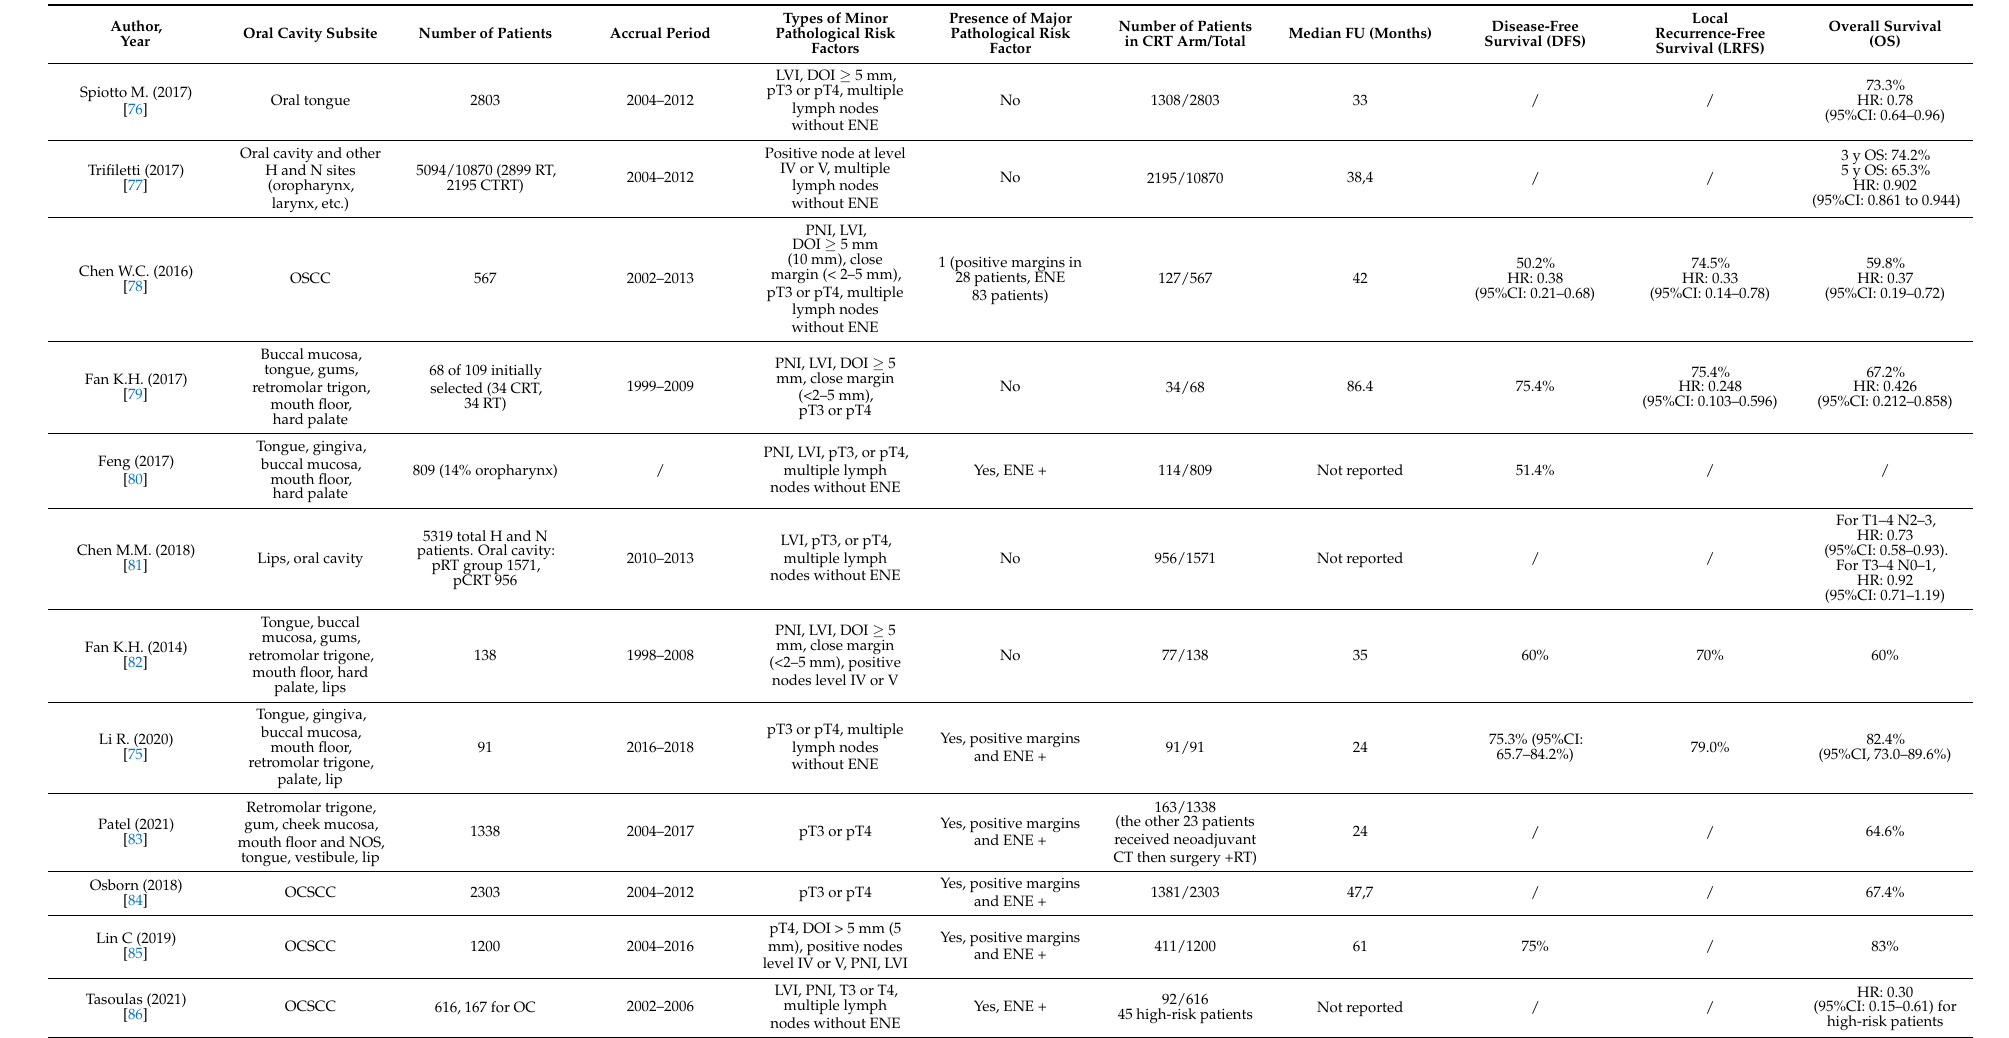
Table 2. Characteristics of studies included in the